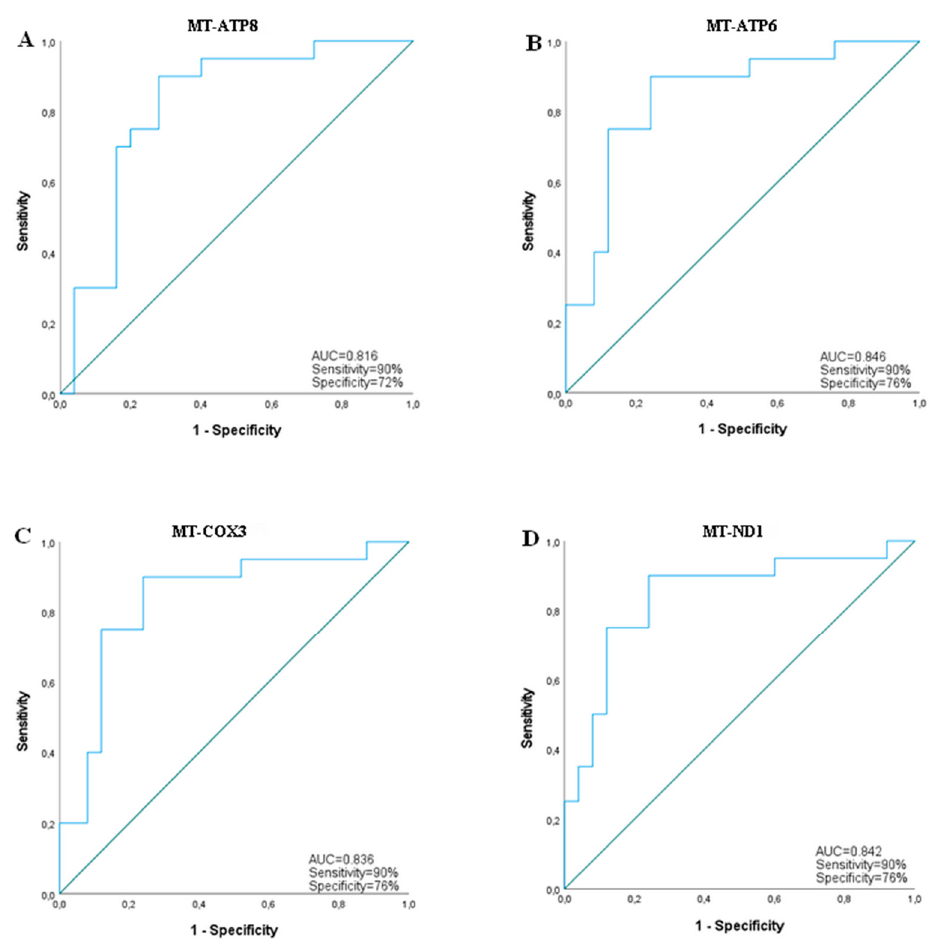
Figure 5. Receiver Operating Characteristic (ROC) analysis for predicting MT-ATP8 ( A ), MT-ATP6 ( B ), MT-COX3 ( C ) and MT-ND1 ( D ) as biomarkers of kidney function impairment in DKD (eGFR stage G3 versus G2).